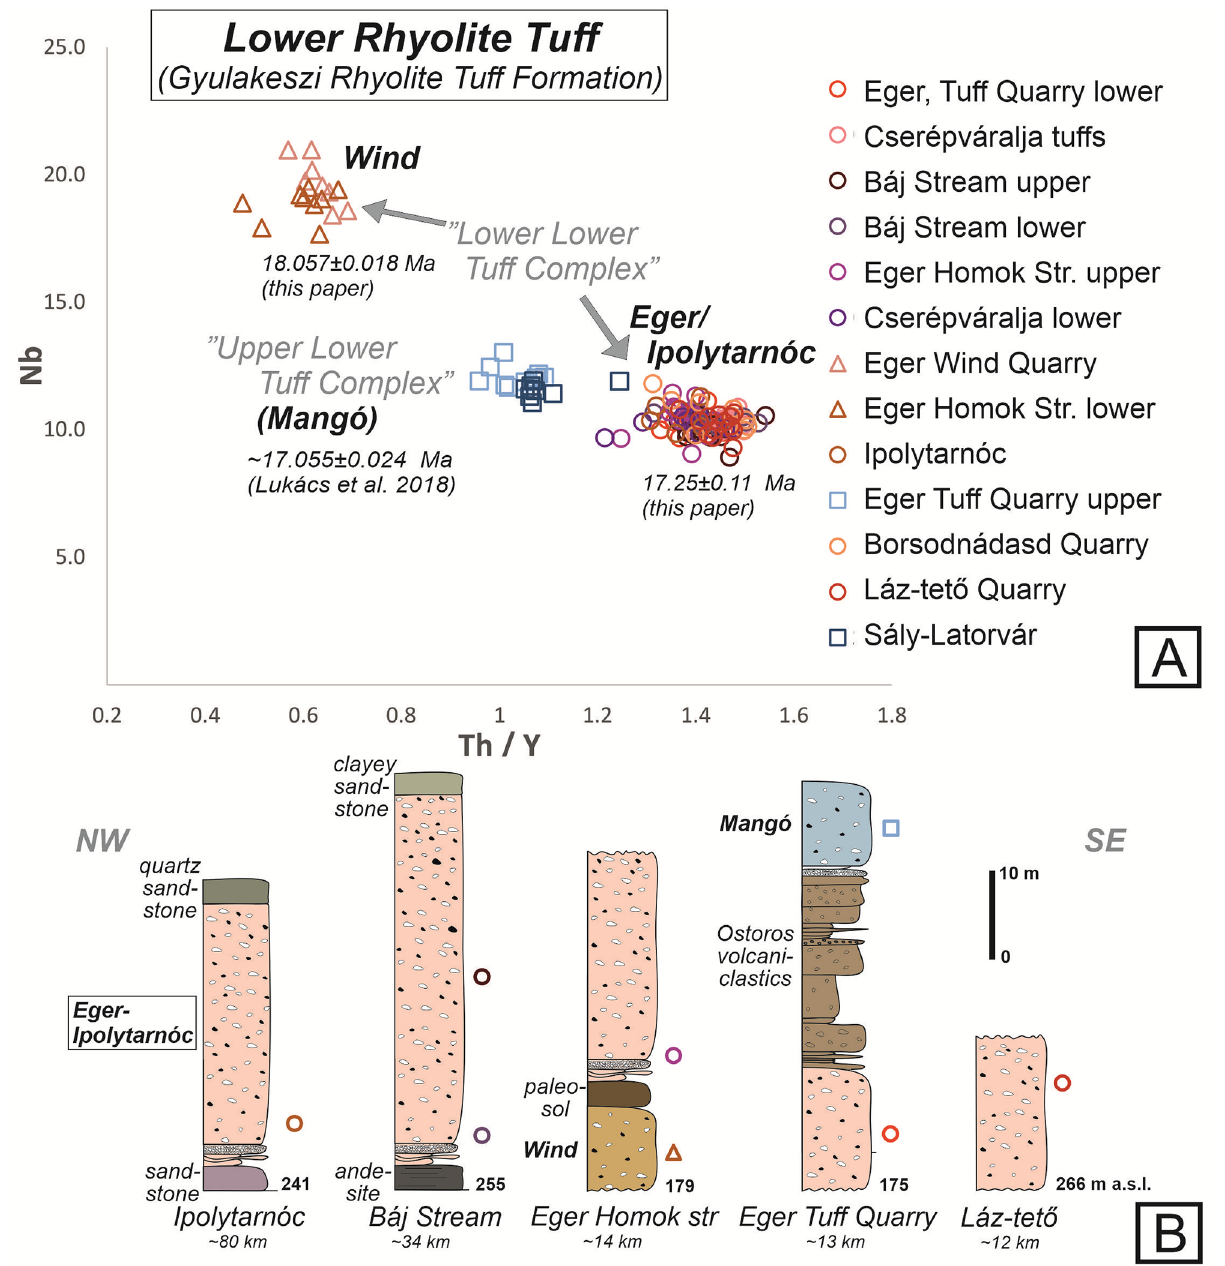
Figure 3. Correlation of units related to the initiation of the Miocene ignimbrite flare-up over the Northern Pannonian Basin. ( A ) Nb vs Th/Y plot of pumice glass of selected rhyolitic ignimbrite samples from North Hungary. For sample locations, see Fig. 1. Analytical data are provided in Supplement 2. ( B ) Simplified stratigraphic logs of study sites in the same area included in this study. The “Lower Lower Tuff Complex” consists of the oldest Wind Ignimbrite and the subsequent Eger-Ipolytarnóc Ignimbrite, followed by the “Upper Lower Tuff Complex” or Mangó